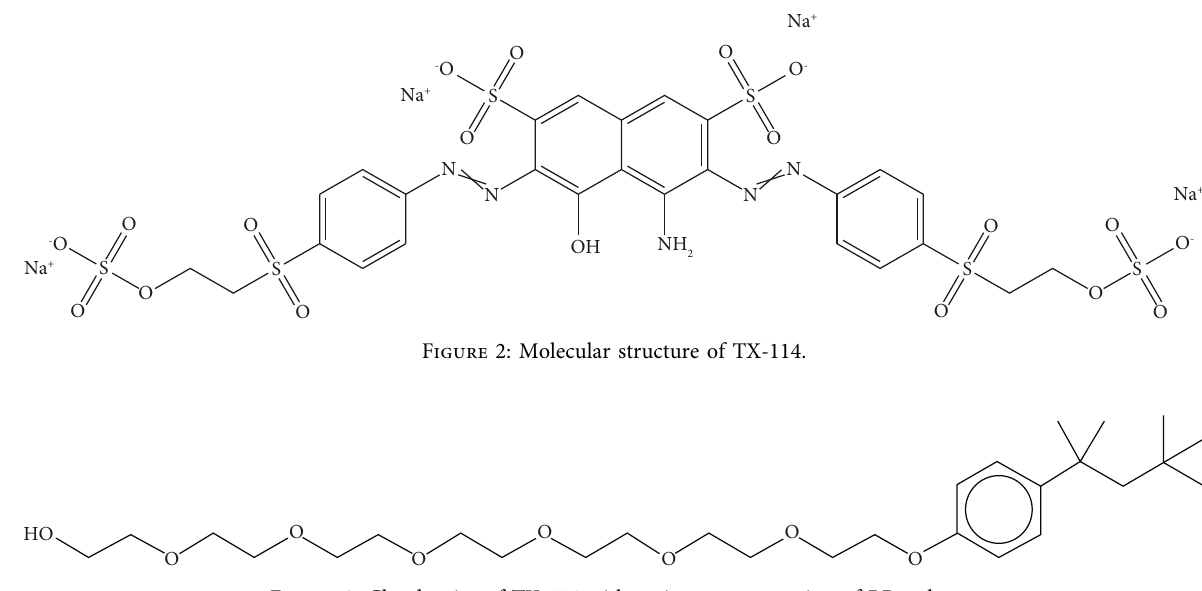
Figure 2: Molecular structure of TX-114.